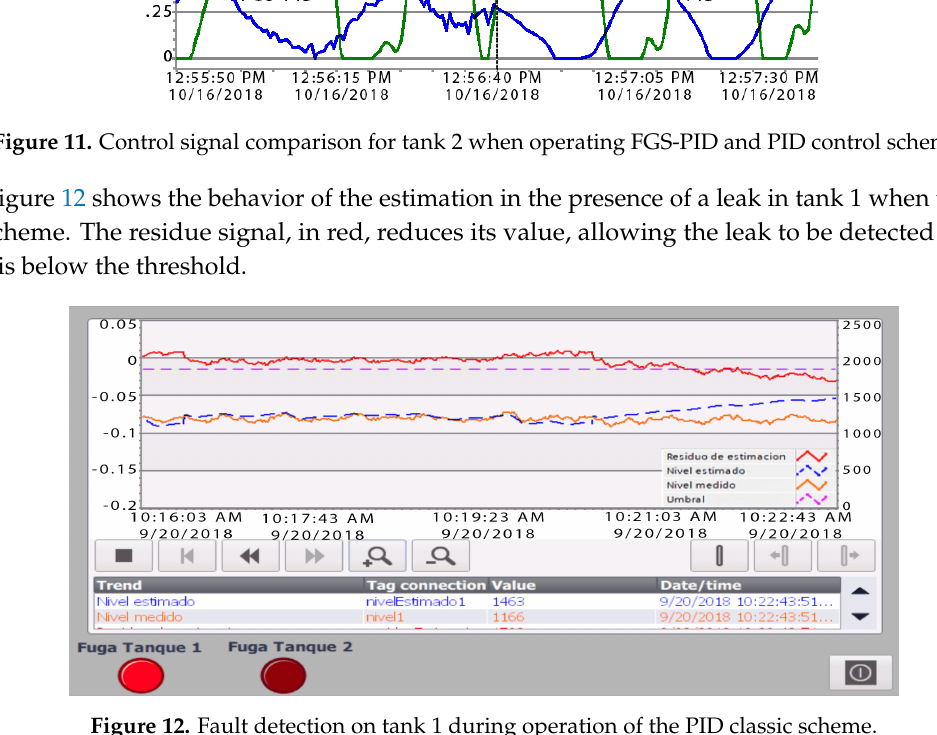
Figure 12. Fault detection on tank 1 during operation of the PID classic scheme.